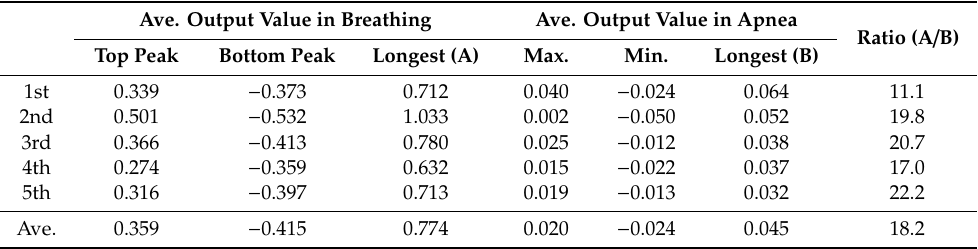
Table 3. Average output values of top and bottom peaks in breathing and the maximum and